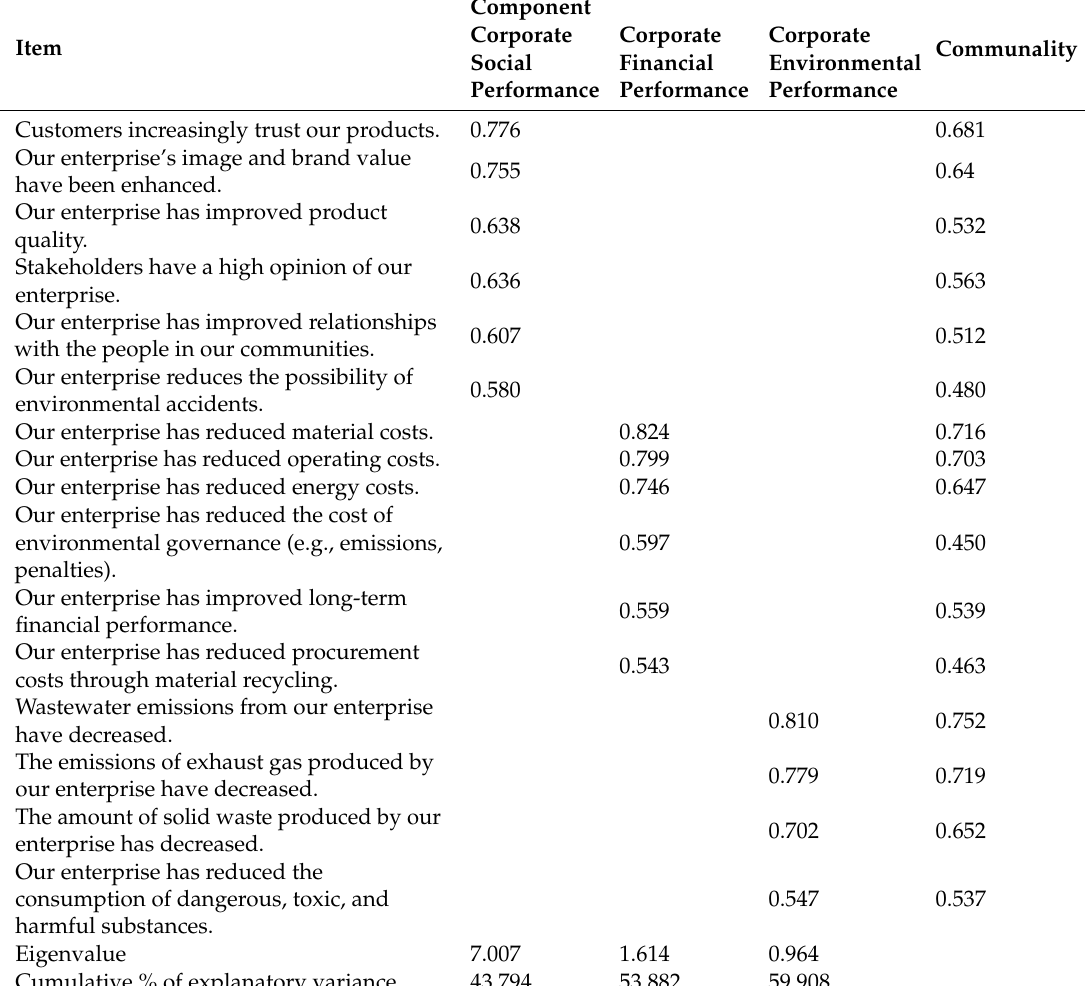
Table 10. Component and factor loadings of the GDP-IE sub-scale ( N = 853).